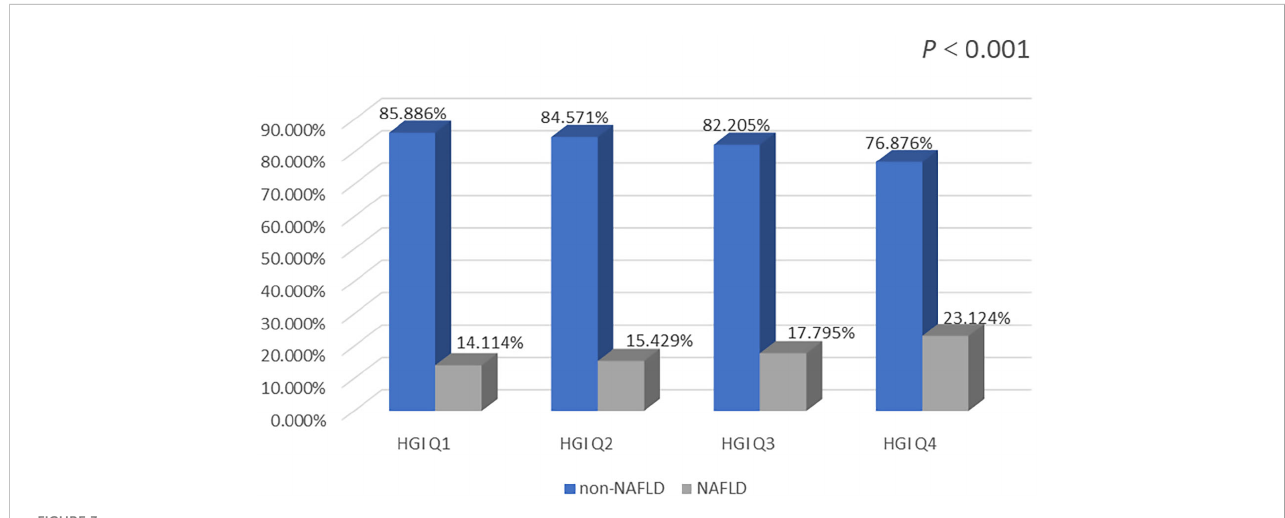
FIGURE 3 Comparison of NAFLD prevalence at different HGI